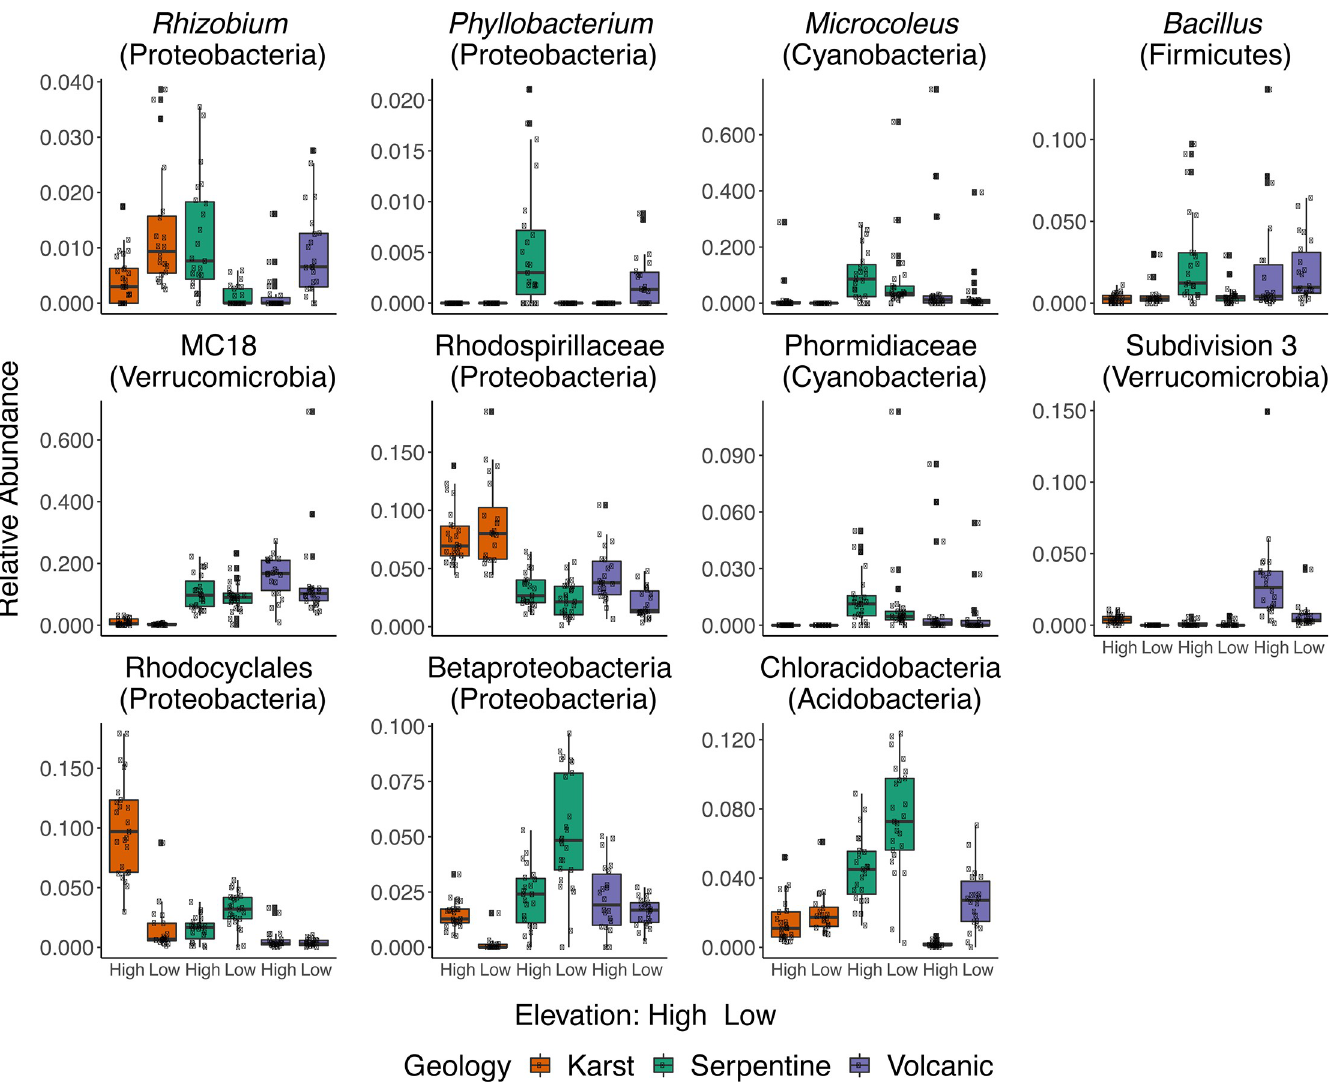
Fig 5. Boxplots of significantly discriminant taxa-level analyses according to both geology and altitude, via LEfSe (Linear discriminant analysis effect size) algorithm. Taxa shown here correspond mostly to genus-level or to the lowest unclassified taxa. Phyla are in parenthesis.